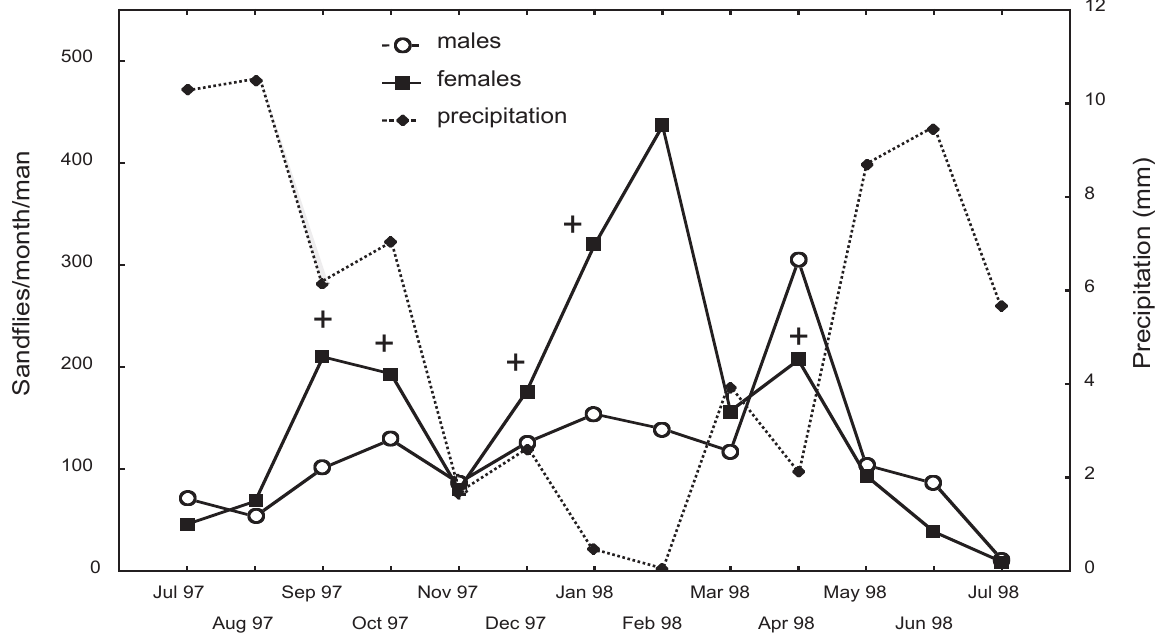
Fig. 2. – Monthly fluctuations of Lutzomyia spinicrassa in Catárnica, Táchira State, Venezuela and occurrence of infected females (+).